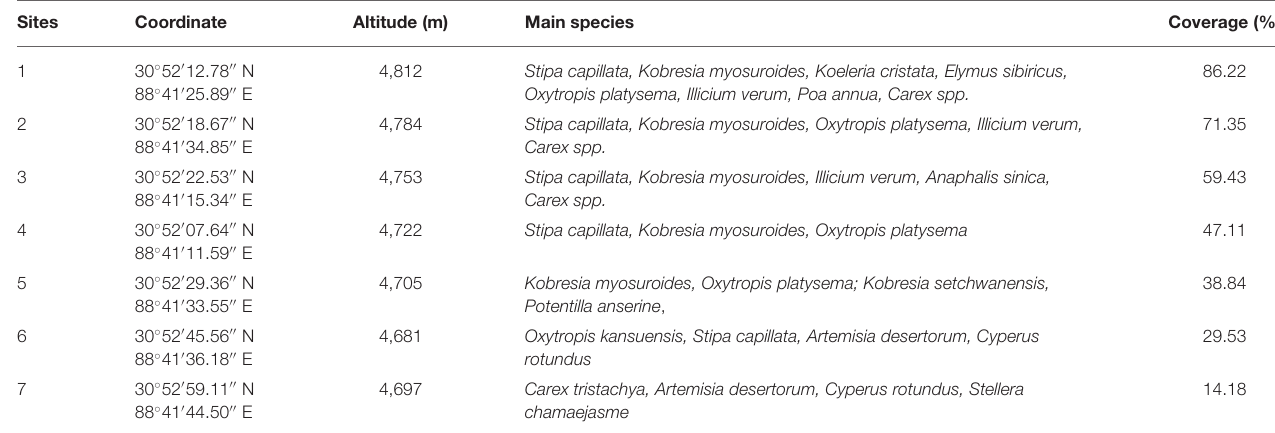
TABLE 1 | The information of the seven sites of degraded alpine steppes in our study. Sites